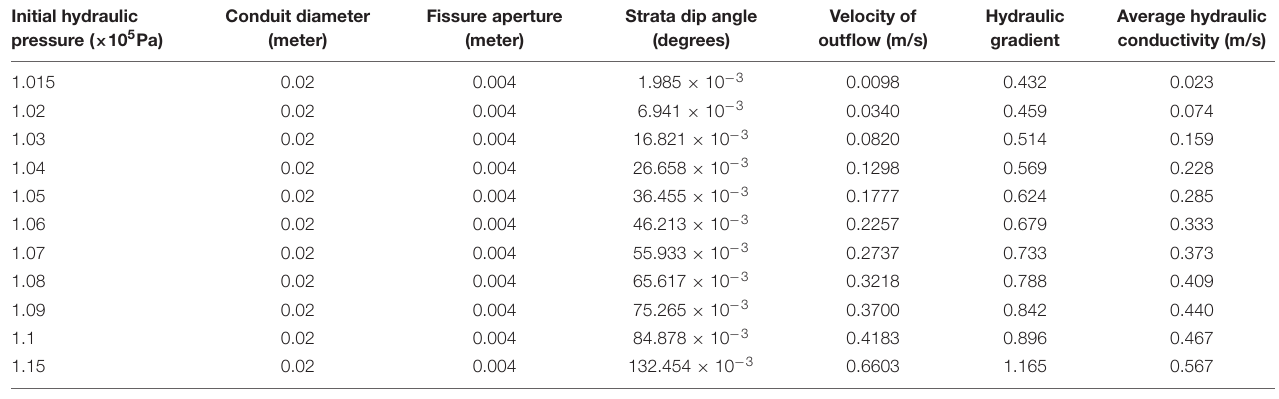
TABLE 5 | The simulation results while varying the initial hydraulic pressure values.